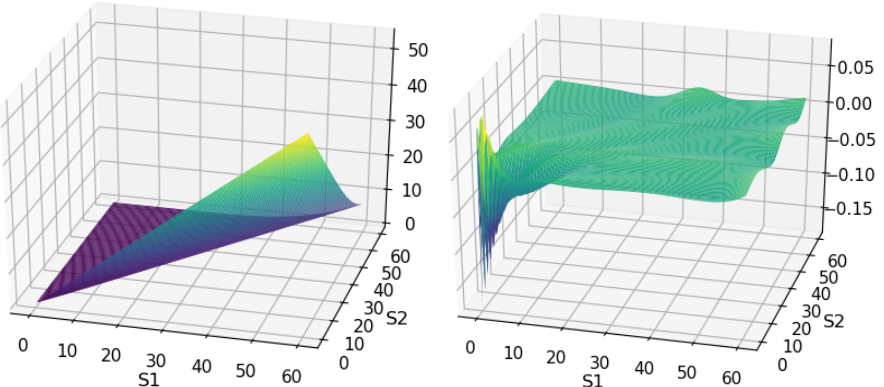
Figure 3. European exchange option ( left ), with parameters: σ 1 = σ 2 = 0.25, ρ = 0.1, r = 0.05, δ i = 0.1, S 1 ∞ = S 2 ∞ = 60 and loss weight λ = 0.5. The error surface, comparing with the analytical solution ( right ).